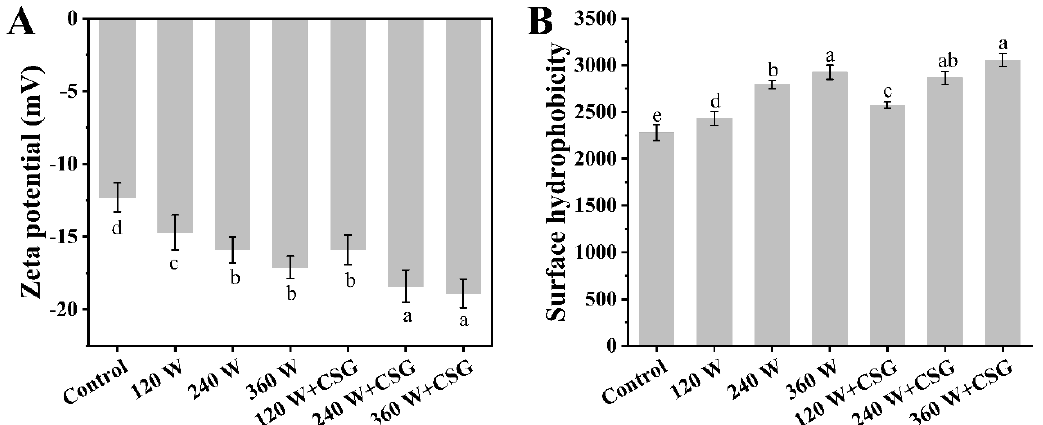
Figure 3. The zeta potential ( A ) and surface hydrophobicity ( B ) of WPI and WPI–CSG systems treated by different power ultrasound. Different lowercase letters represent significant differences ( p < 0.05) between data.